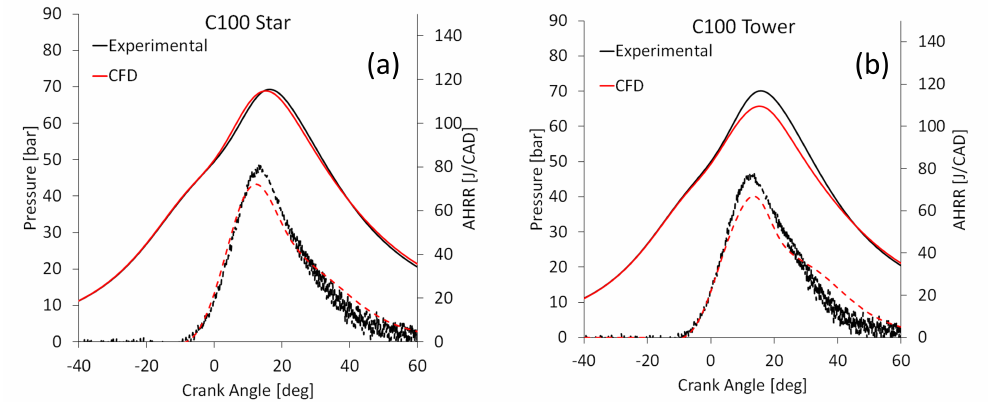
Figure 14. Comparison between the computed and experimental data of the in-cylinder pressure (solid lines) and apparent heat release rate (dashed lines) for the C100 operating point when using the star ( a ) and tower ( b ) pistons.